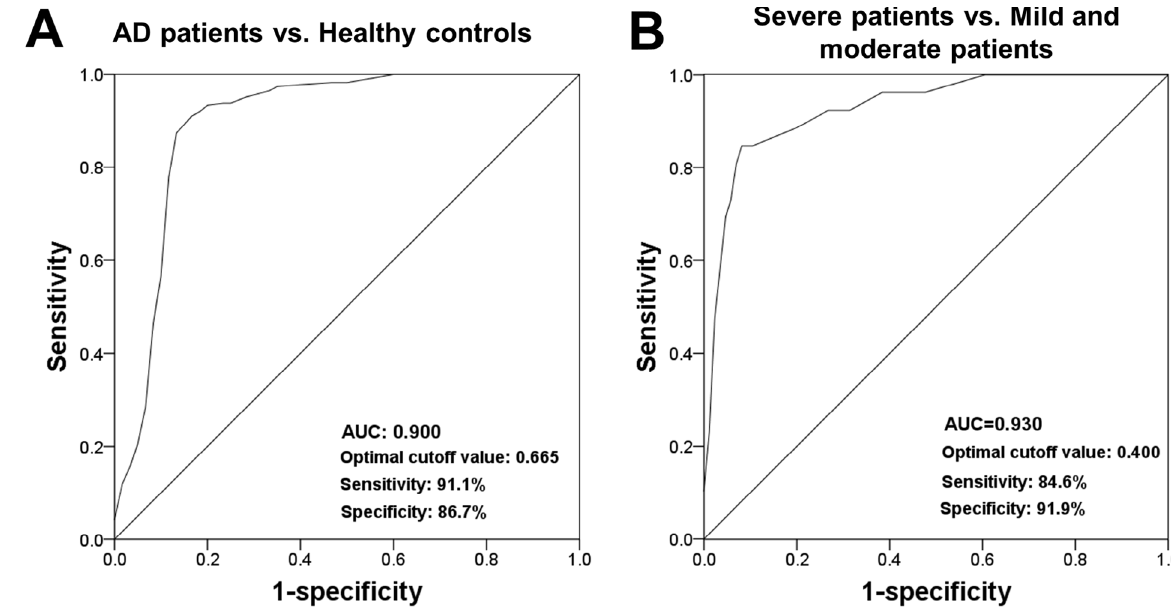
Figure 3 - ROC curves based on serum miR-149 levels in AD patients. A . A ROC curve based on serum miR-149 to distinguish AD patients from healthy volunteers. B . A ROC curve based on serum miR-149 to screen AD cases with severe dementia from AD patients with mild and moderate dementia. AUC, area under the curve.